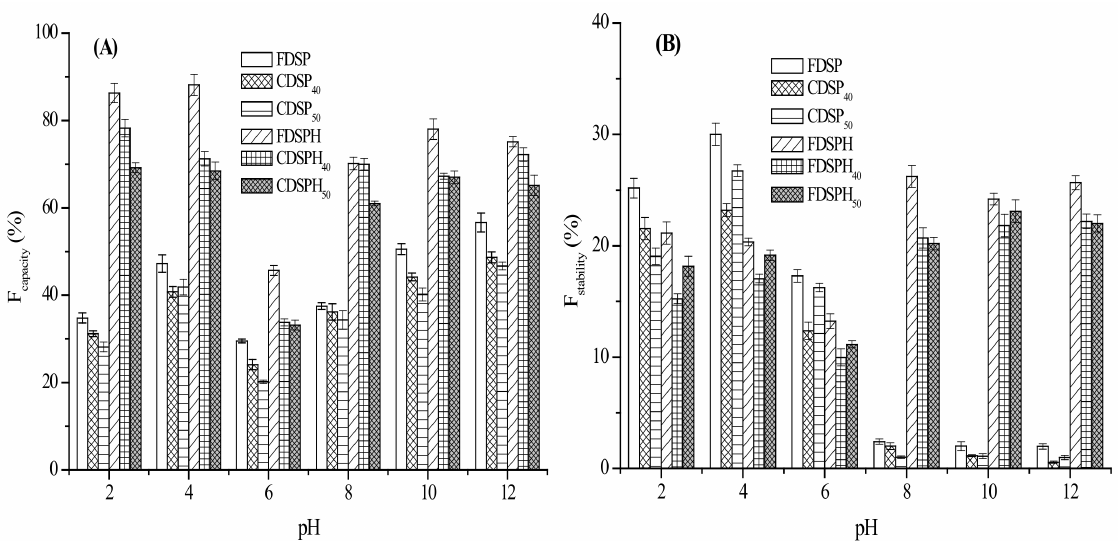
Figure 2. Foaming capacity ( A ) and stability ( B ) of freeze- and convectively-dried SP and